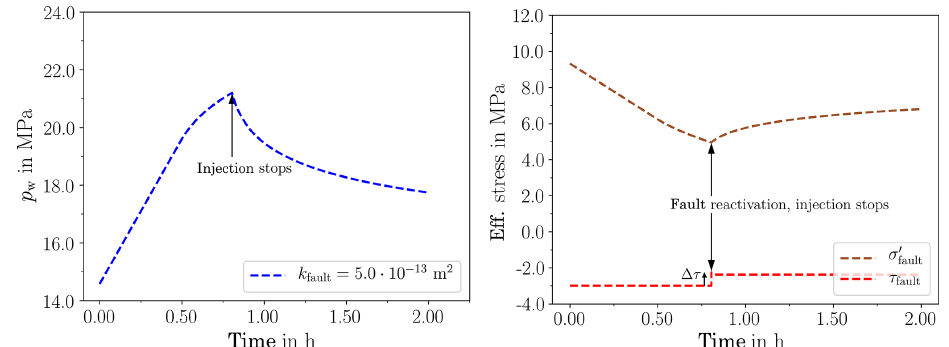
Figure 2. Pressure and stress evolution (effective stress σ (cid:48) and shear stress on the fault τ fault ) over time at the injection cell in the fault in 1475m depth for a fault permeability k fault = 5 × 10 − 13 m 2